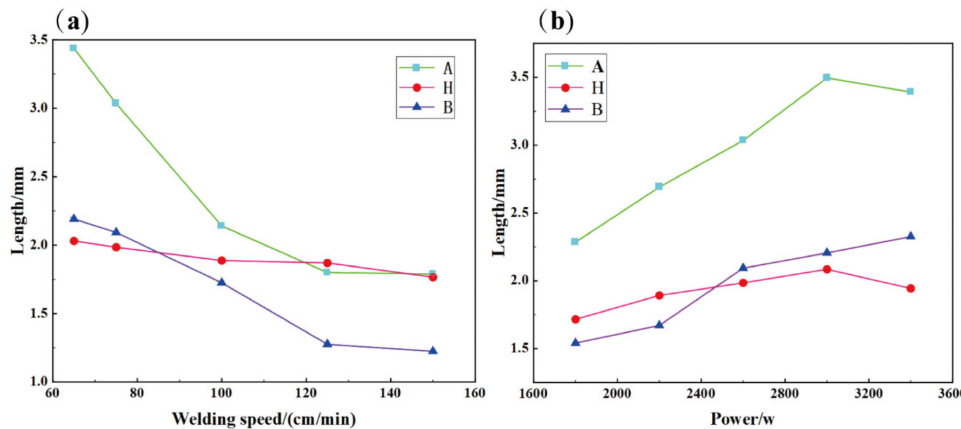
Figure 13. Changes in the parameters of the weld shape with: ( a ) welding speed; ( b )